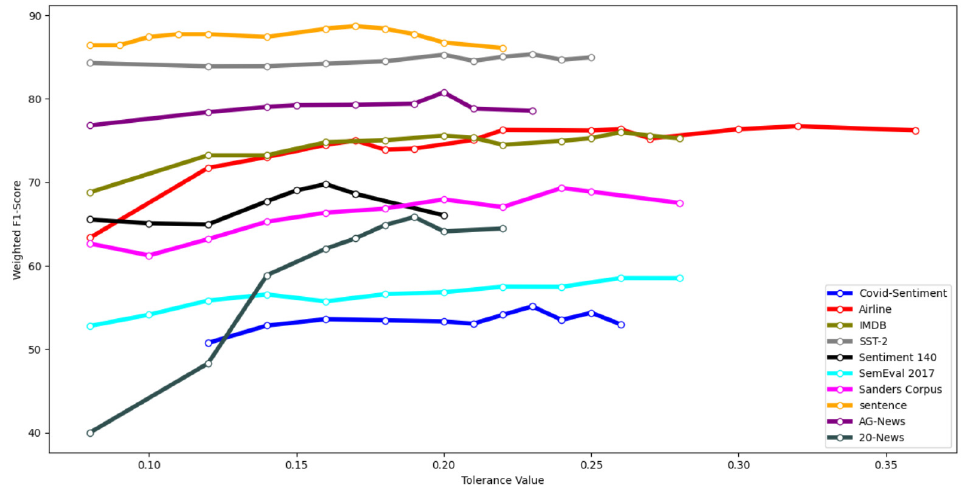
Figure 3. TSC Algorithm: Weighted F1-score for all datasets using mean-value (TSC-mean) prototype vectors for different ε values.